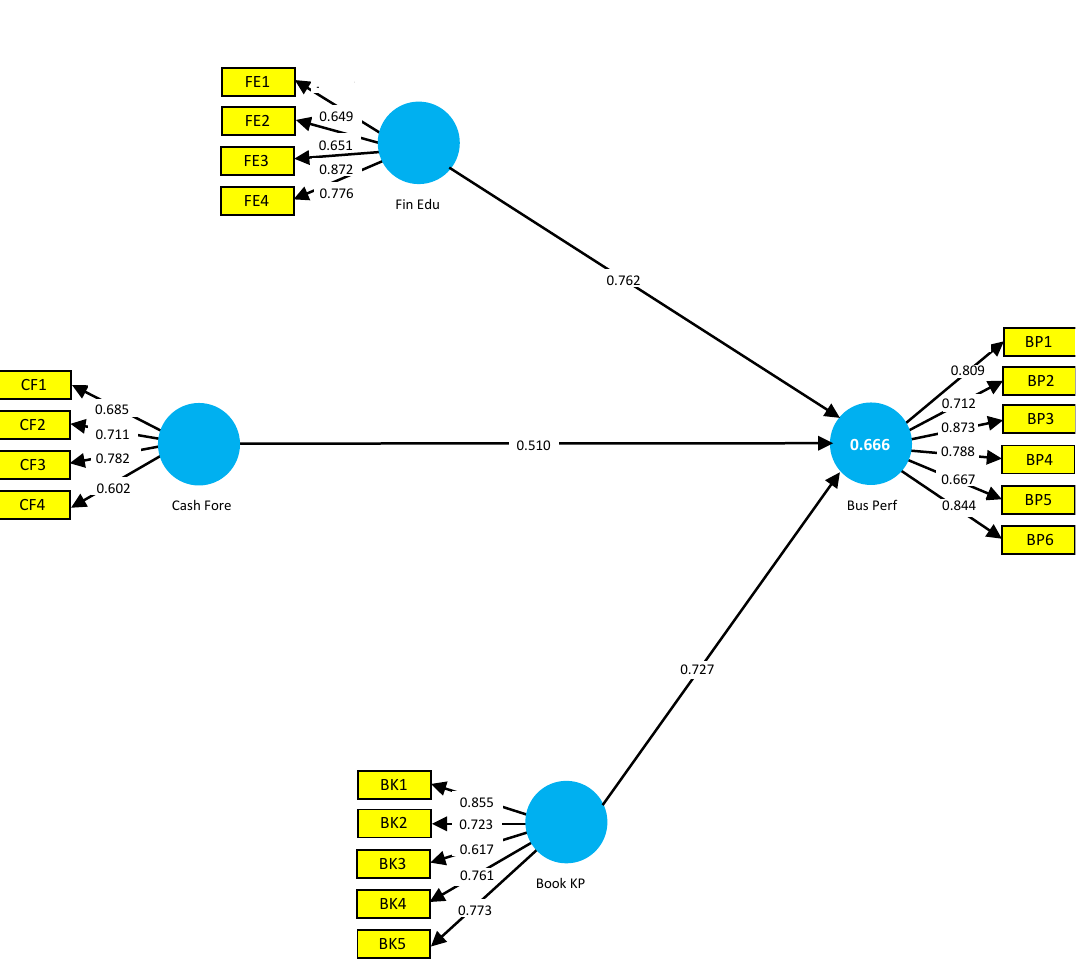
Figure 1. Measurement model assessment Table 3. Construct validity and